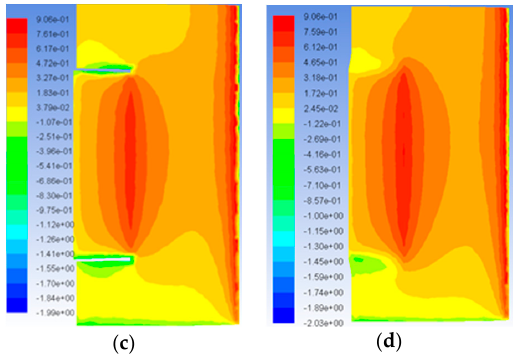
Figure 19. The pressure coefficient ( a ) Conventional wing upper surface; ( b ) Initial morphing Wing Upper Surface; ( c ) Conventional wing lower surface; ( d ) Initial morphing Wing lower Surface.